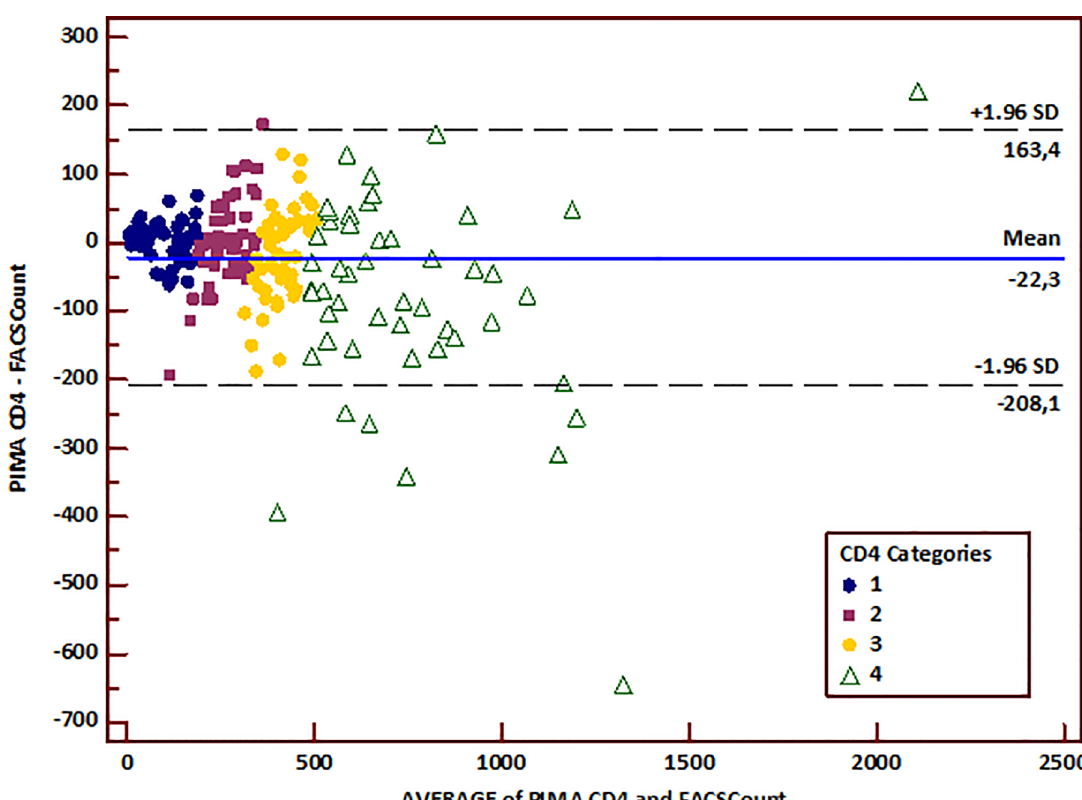
Fig 2. Bland-Altman plot of the whole data. The x-axis represents the average of CD4 count between the PIMA and the BD FACSCount TM , and the y-axis represents the bias (difference) between the PIMA TM Alere and the BD FACSCount TM . The solid blue line represents the mean of the difference between the two measurements, and the light black lines represent the upper and lower limits of agreement (ULA: mean differences plus and 1,96 x standard deviation of the mean difference; LLA: mean differences minus and 1,96 x standard deviation of the mean difference). Legend for CD4 categories: 1: CD4 T- cells < 200/mm 3 ; 2: CD4 T-cells between 200 and 350/mm 3 ; 3: CD4 T-cells between 351 and 500/mm 3 ; 4: CD4 T-cells above 500/mm 3